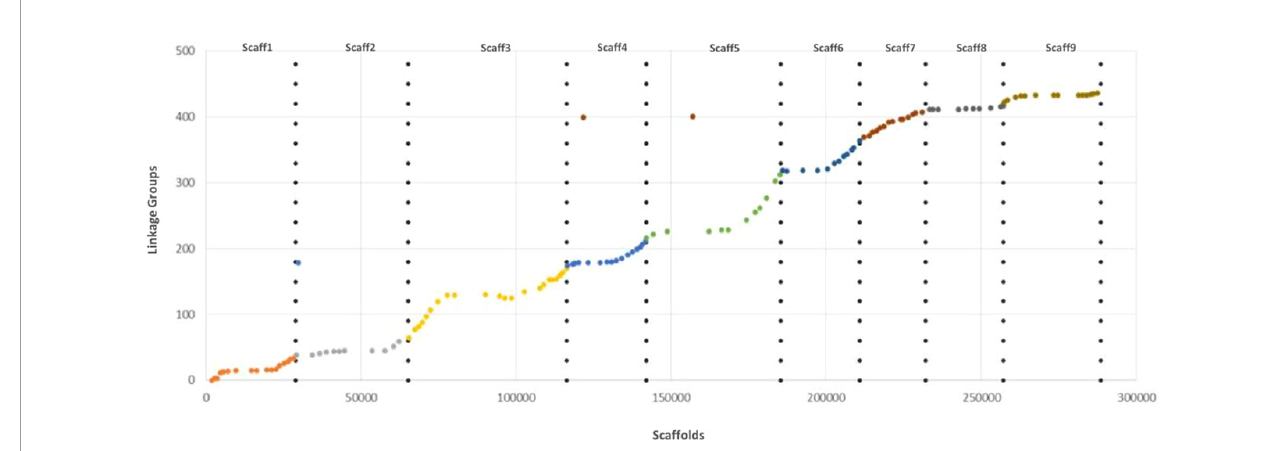
FIGURE 6 | Marey map plot constructed with the 131 genetically mapped SNPs; x axis, physical positions on the clementine reference genome; y axis, positions on the ‘ Giant Key ’ lime genetic